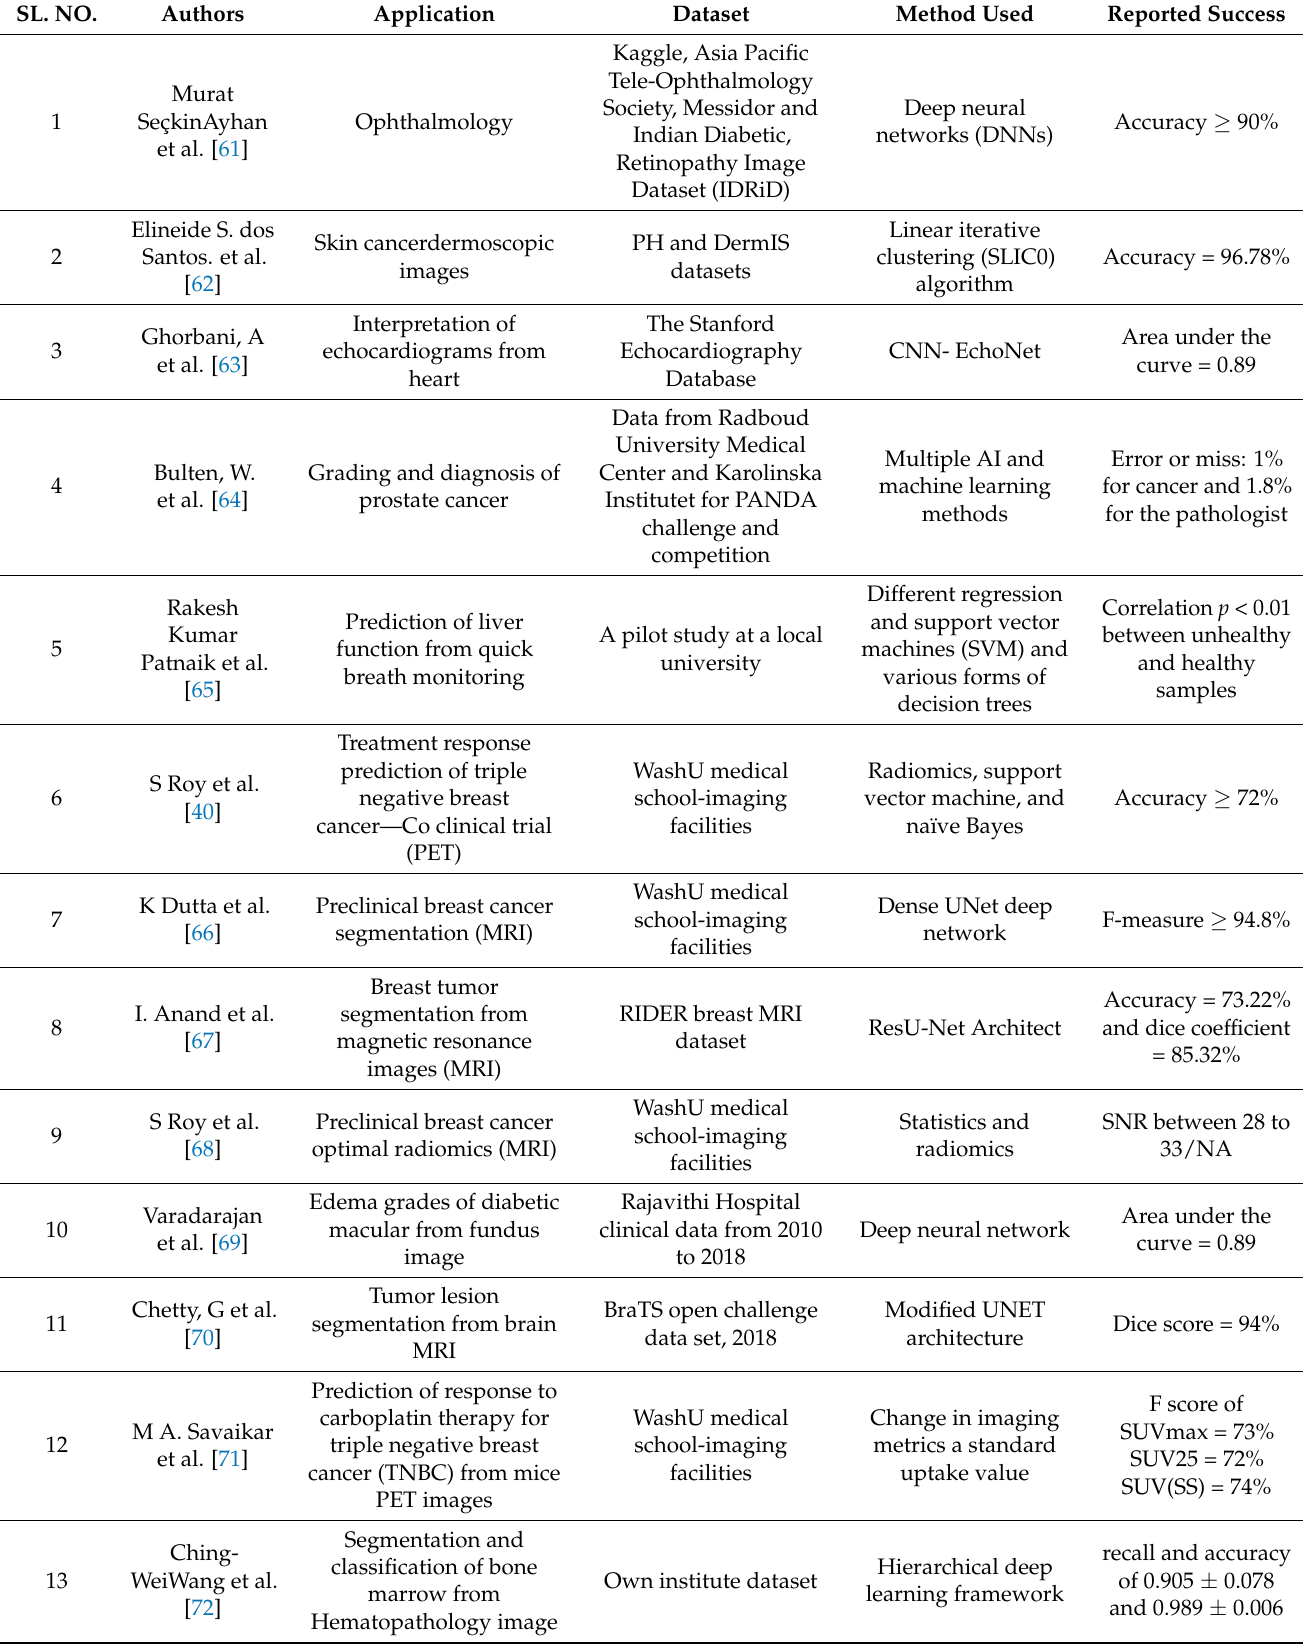
Table 4. Reported success and comparative analysis for the detection of different